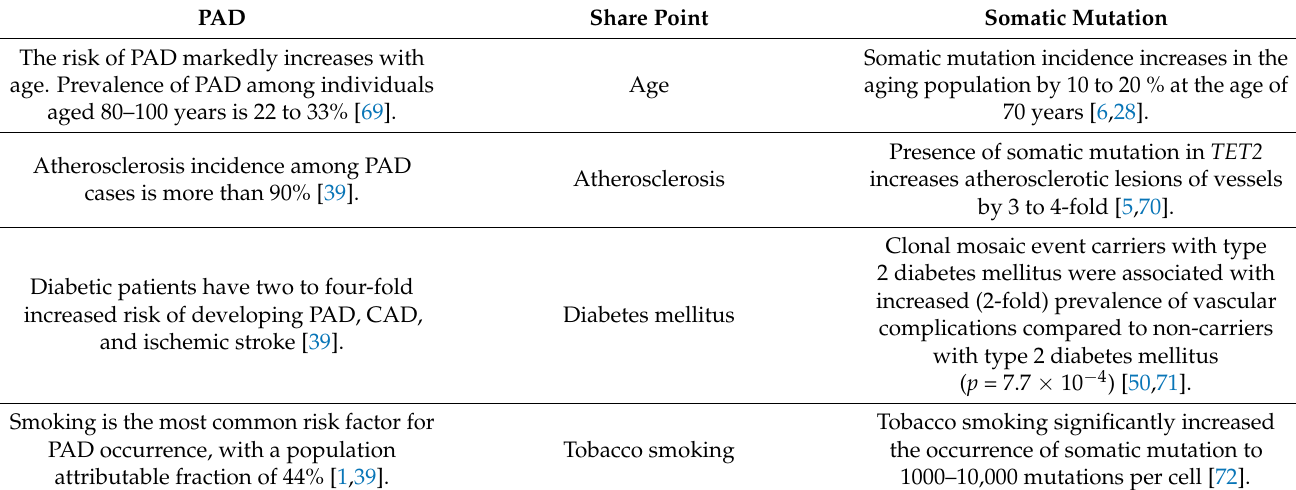
Table 5. Evidence-based information on peripheral artery disease (PAD) and somatic mutations. PAD Share Point Somatic Mutation The risk of PAD markedly increases with Somatic mutation incidence increases in the age. Prevalence of PAD among individuals Age aging population by 10 to 20 % at the age of aged 80–100 years is 22 to 33% [69]. 70 years [6,28]. Presence of somatic mutation in TET2 Atherosclerosis incidence among PAD Atherosclerosis increases atherosclerotic lesions of vessels cases is more than 90% [39]. by 3 to 4-fold [5,70].